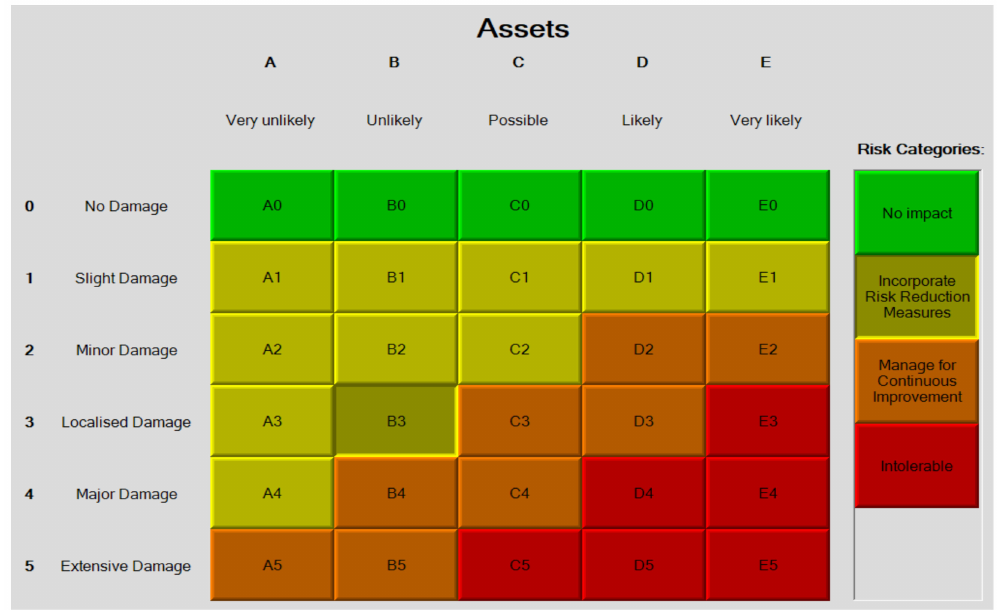
Figure 2. Risk matrix analysis of distortions in electrical